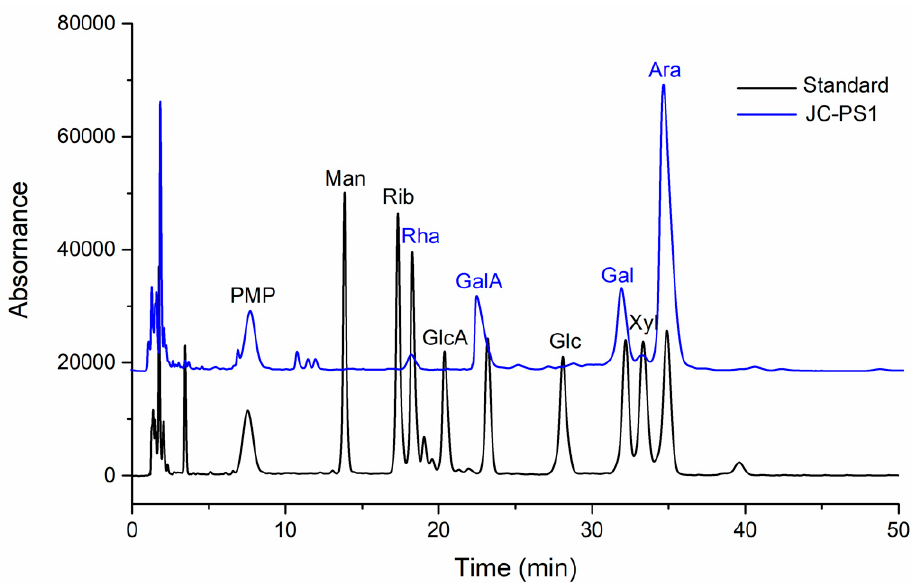
Figure 2. The PMP-LC-MS chromatogram of monosaccharide composition analysis of JC-PS1.